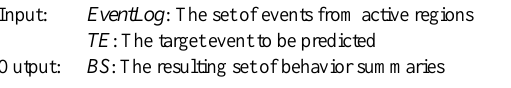
Table 1. Summary and discovery algorithm of BPL